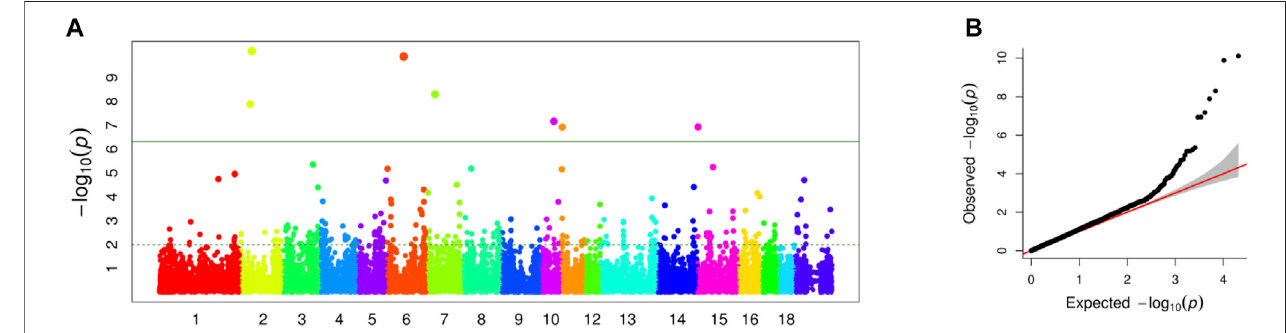
FIGURE 2 | (A) Manhattan plot of association results for sow milk production ability. The green line indicated p (cid:1) 1.36E-06. (B) Quantile-quantile plot of 36,871 SNPs in genome-wide association study for milk production